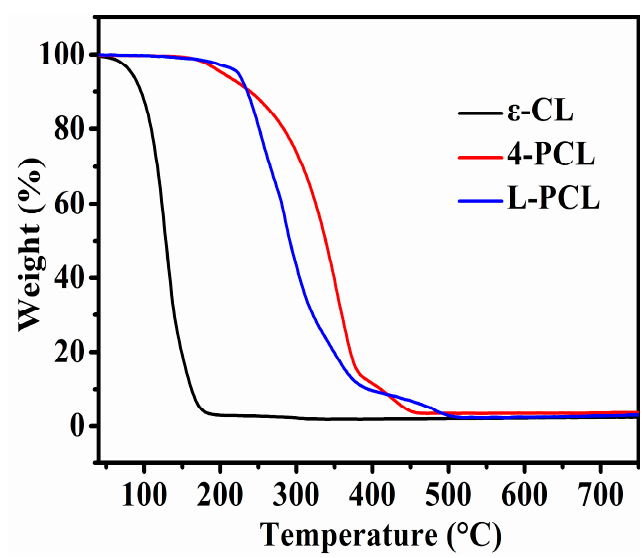
Figure 3. The TG curves of ε -CL, 4-PCL and L-PCL.